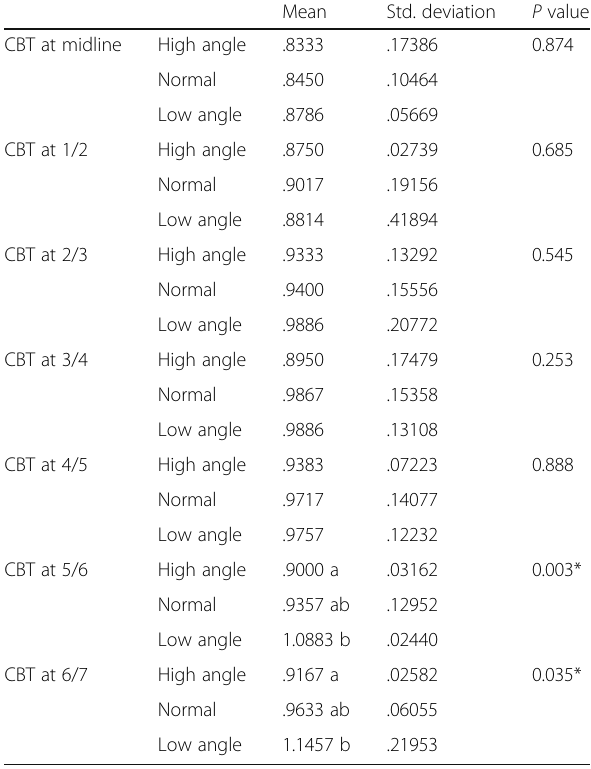
Table 1 Measurements of buccal inter-radicular cortical bone thickness at 4 mm from the alveolar crest in the upper arch Mean Std. deviation